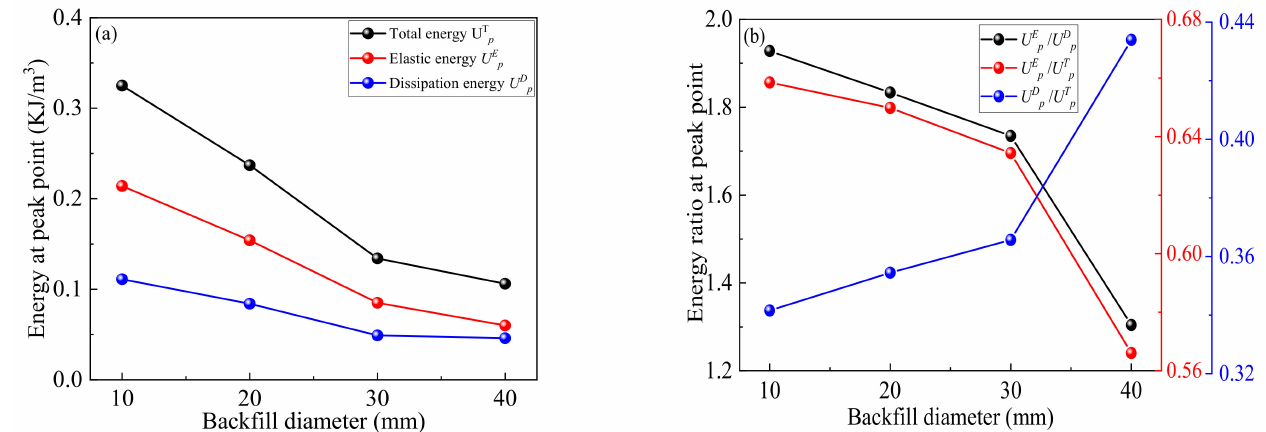
Figure 9. Energy and energy ratio at the peak point: ( a ) energy; ( b ) energy